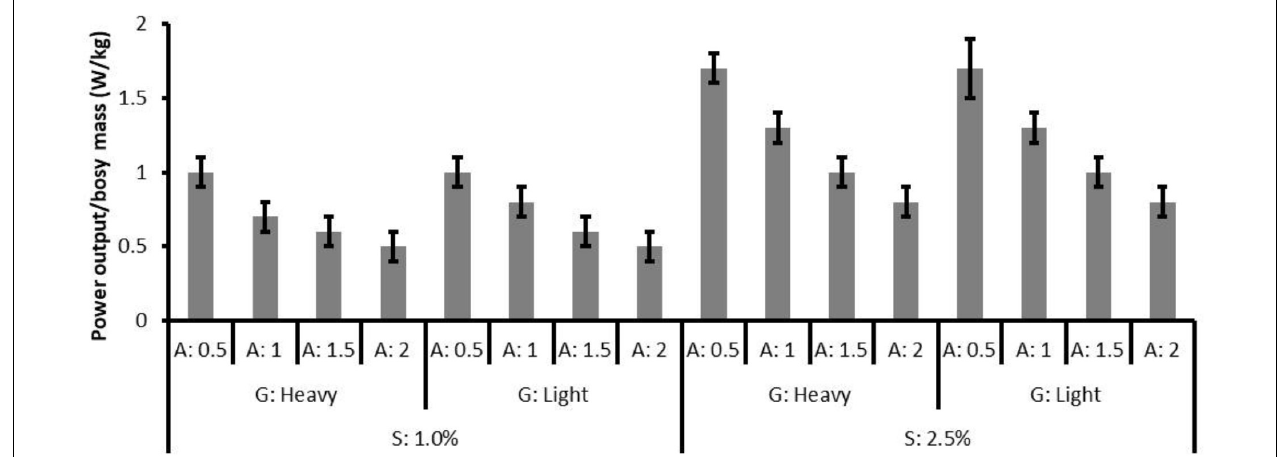
FIGURE 4 | The mean and standard deviation of normalized power output (W/kg) in all conditions.